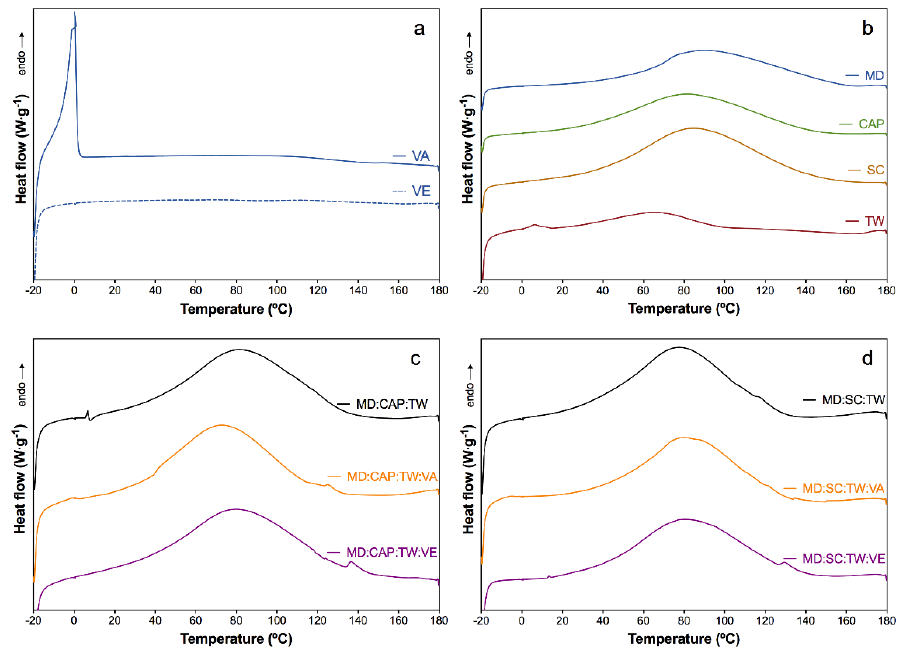
Table 3. Peak temperature (T p ) and enthalpy values (Δh) of the main endothermic events in the first heating scan.